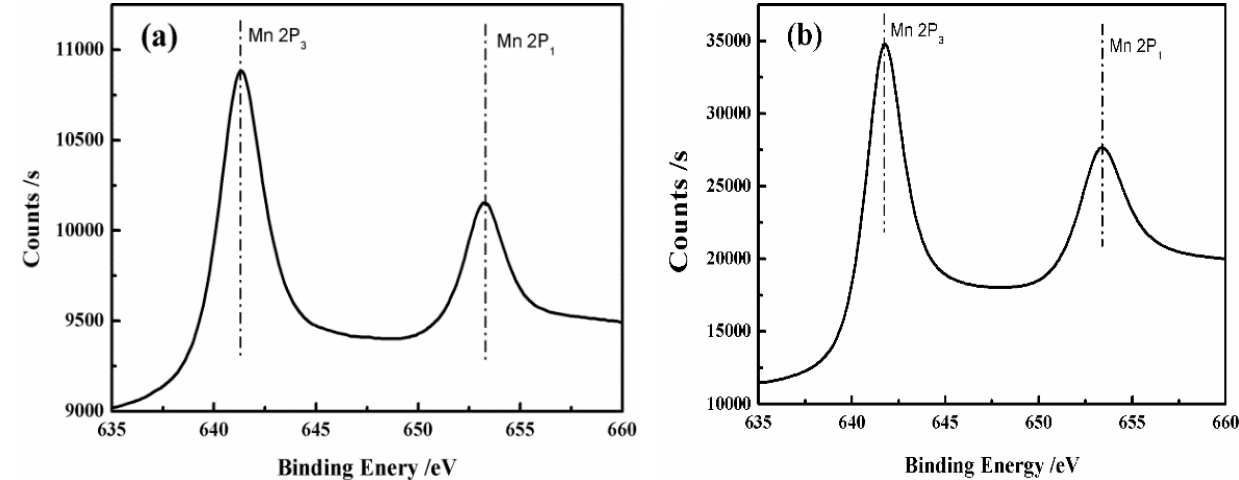
Figure 6. XPS spectra of the Mn2P region of samples: ( a ) Mn 3 O 4 /PTFE hollow fiber membrane; ( b ) MnO 2 /PTFE hollow fiber membrane.